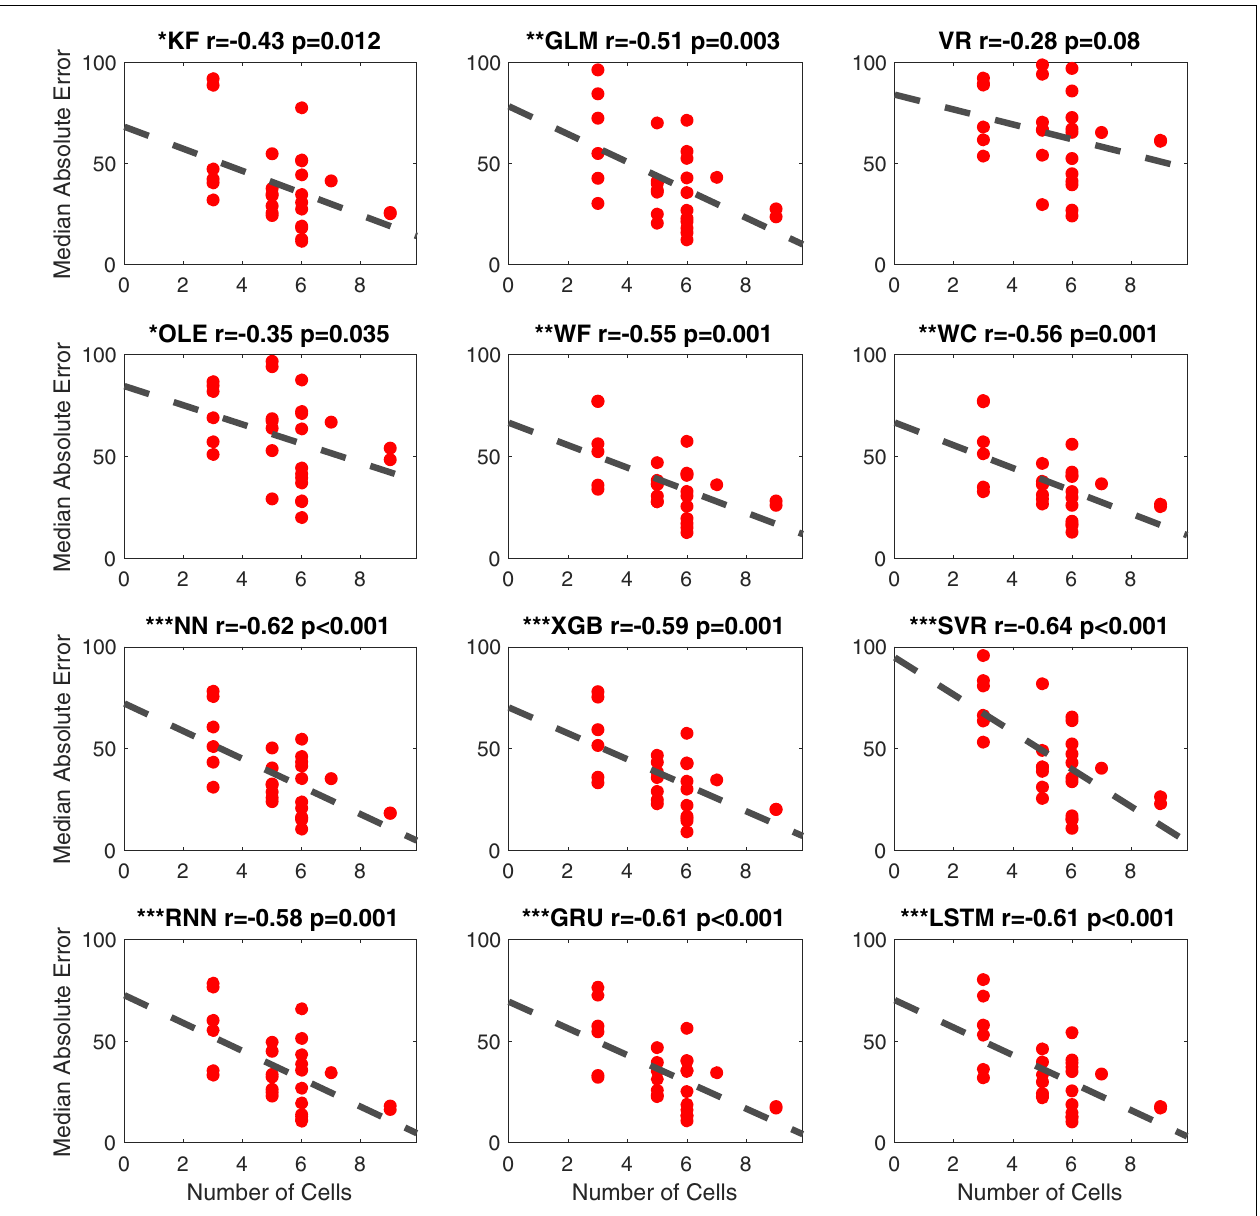
FIGURE 10 | Scatterplots of median absolute error vs. number of cells for all 12 methods. The dashed line is the fitted linear regression. The correlation coefficient (r) and the corresponding p -value are shown on the top-right corner of each panel. The significance levels are shown with symbols on the top-left corner ∗∗∗ p < 0.001; ∗∗ p < 0.01; ∗ p < 0.05. KF, Kalman Filter; GLM, Generalized Linear Model; VR, Vector Reconstruction; OLE, Optimal Linear Estimator; WF, Wiener Filter; WC, Wiener Cascade; SVR, Support Vector Regression; XGB, XGBoost; FFNN, Feedforward Neural Network; RNN, Recurrent Neural Network; GRU, Gated Recurrent Unit; LSTM, Long Short-Term